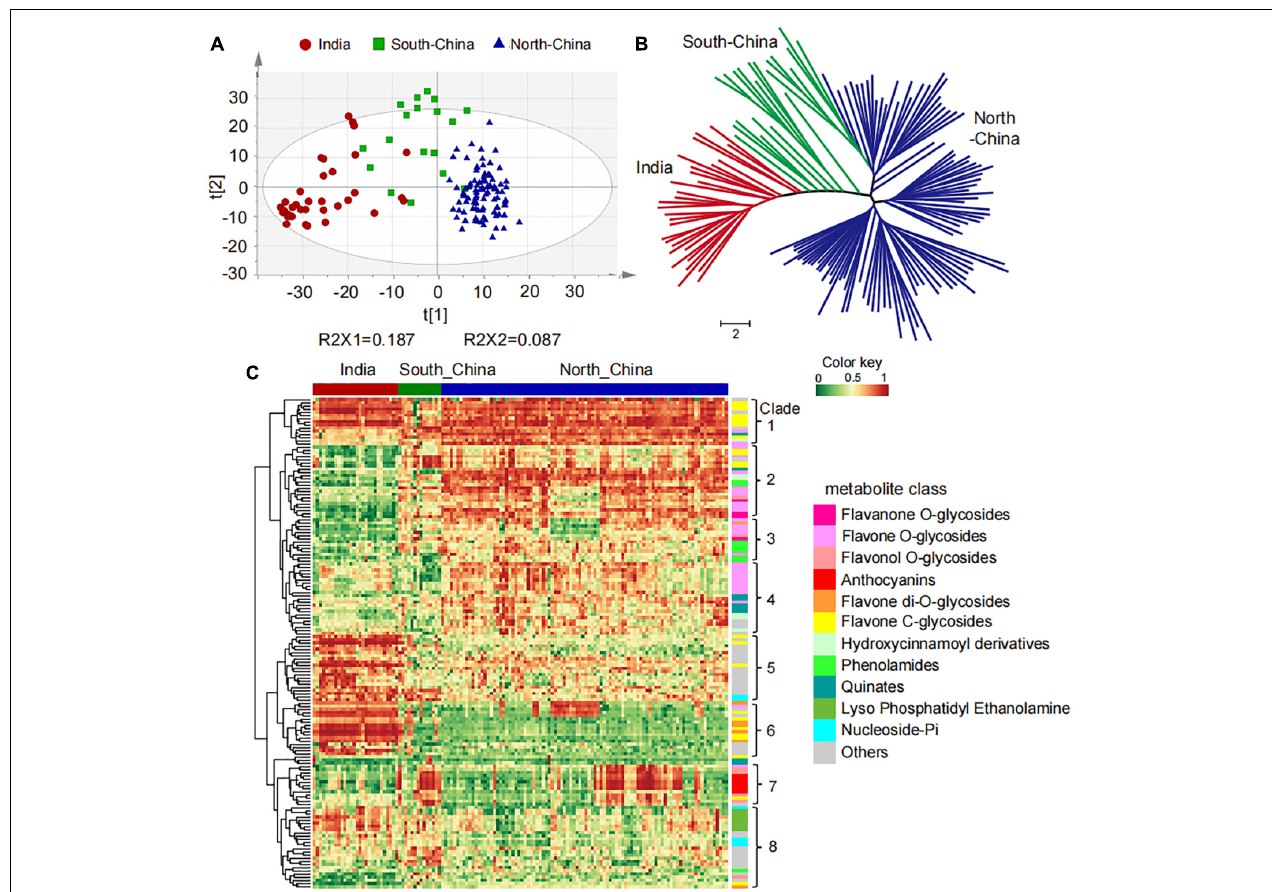
FIGURE 1 | Natural variation and population structure of 150 millet accessions based on metabolic profiling. (A) Score plot of principal component analysis (PCA) for datasets of millet leaf metabolites. The red, green, and blue dots represent samples from India, the south and north of China, respectively. (B) Neighbor-jointing phylogenetic tree of 150 millet accessions with leaf metabolites. Three major clades, represented by India (clade I), South-China (clade II), and North-China (clade III), were identified from the tree. The scale bar indicates the simple matching distance. (C) Heatmap visualization of relative differences of metabolites that showed significant differential accumulation among Indian and Chinese millet accessions. Each millet accession is visualized in a single column and each metabolite is represented by a single row. Data of the content value of each metabolite were normalized to complete linkage hierarchical clustering. Red indicates high abundance, and green indicates low relative metabolic